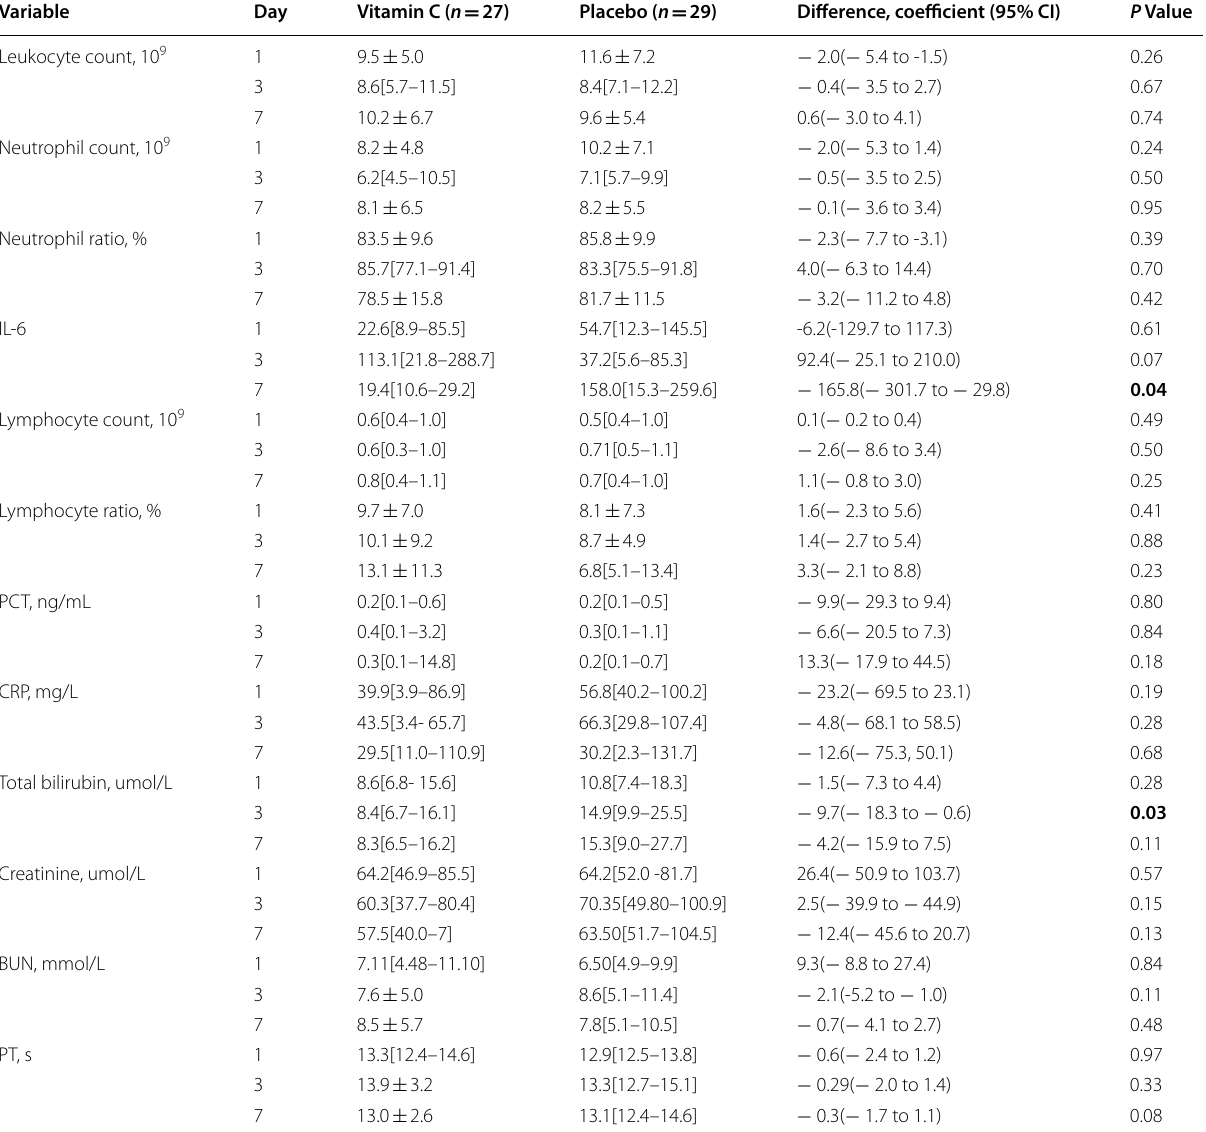
Table 3 Laboratory findings in a trial of HDIVC in patients with